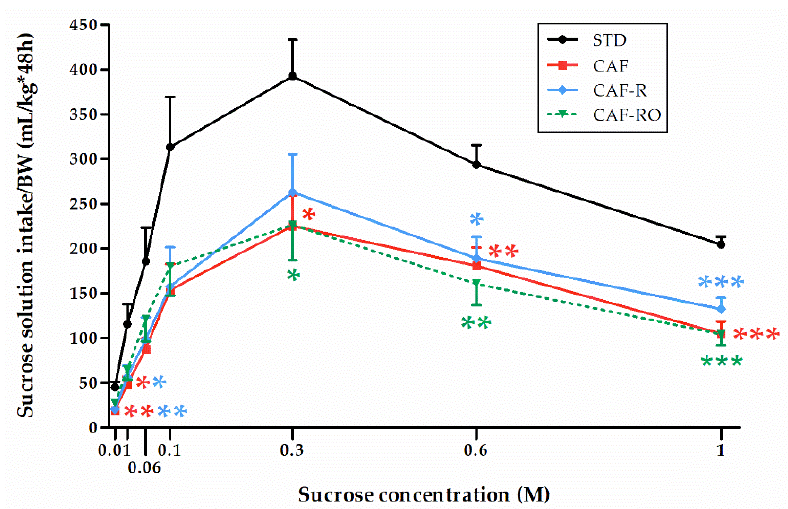
Figure 1. Effects of the dietary treatments on sucrose solution intakes in the two-bottle preference